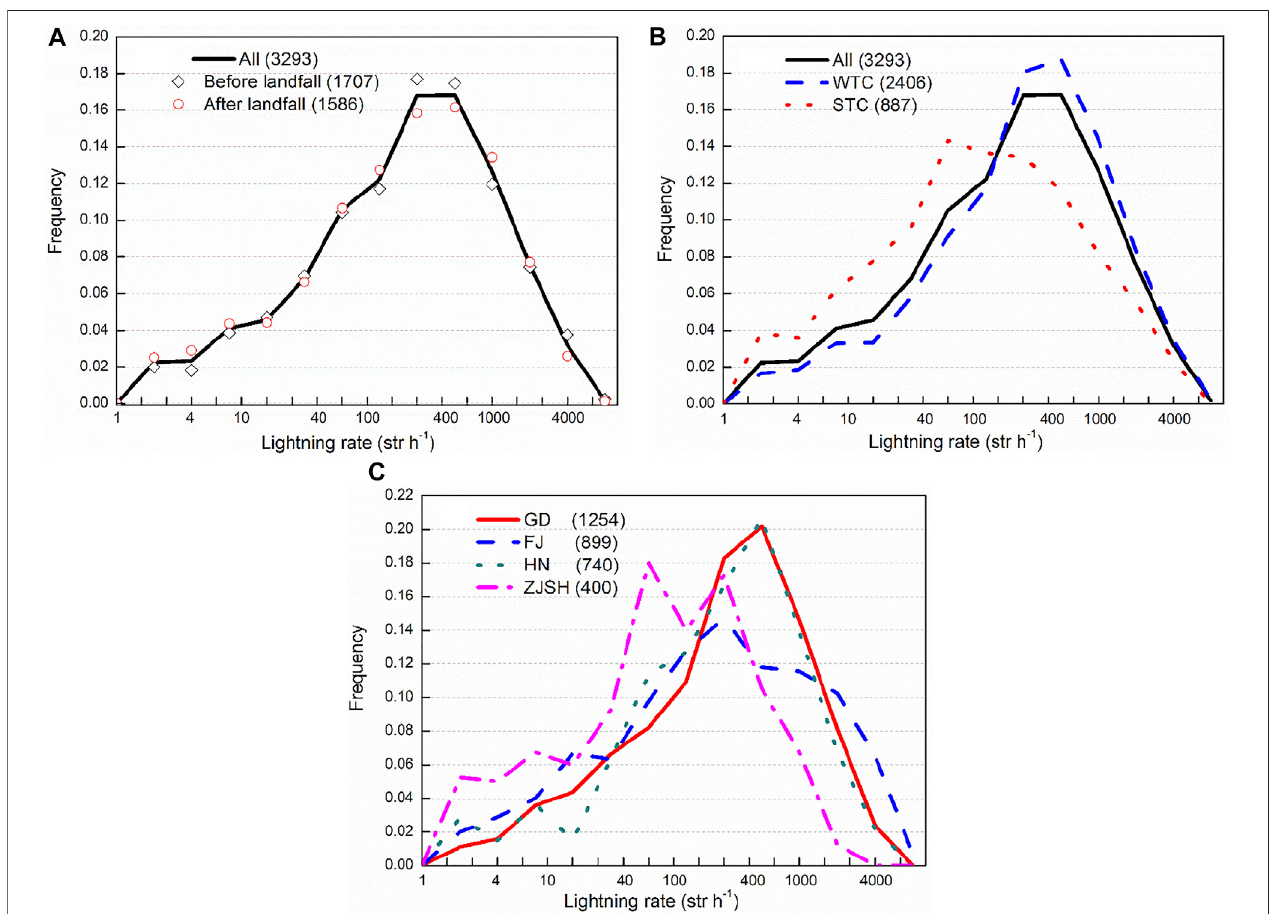
FIGURE 3 | Probability density functions of lightning rates within 500 km of the storm center for (A) before and after landfall groups, (B) weak and strong groups, and (C) landing location groups. The number in parentheses indicates the samples.